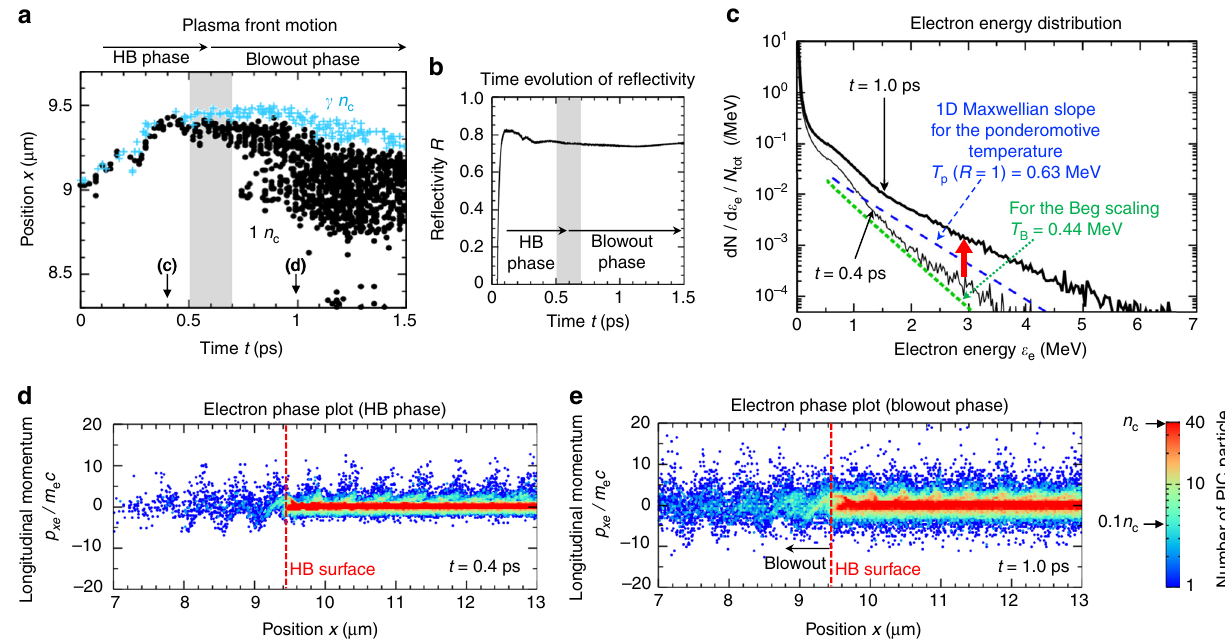
Fig. 2 PIC simulation results for the interaction of the linearly polarized laser fi eld. The laser intensity is the same as that in Fig. 1. a shows the time evolution of positions of the critical density n e = (1 ± 0.1) n c (black dots) and relativistic critical density n e = ( γ ± 0.1) n c (blue crosses), where γ ¼ (cid:4) (cid:5) 1 = 2 is the relativistic factor of electrons and ε 2 = 1 for linearly polarized lasers. In obtaining γ , the re fl ectivity R at the transition time from = 2 1 þ ð 1 þ R Þ ϵ 2 ^ a 2 0 the hole boring (HB) to the blowout is used. b Time evolution of the re fl ectivity. The shaded areas in a , b correspond to the transition interval from the HB to the blowout. In c , the electron energy distributions at t = 0.4 and 1 ps are shown by black thin and bold lines, respectively. The slopes of the one- dimensional relativistic Maxwellian energy distribution function > 0.5 MeV are shown by the blue-dashed and green-dotted lines assuming the ponderomotive temperature at the maximum re fl ectivity R = 1, that is T p = 0.63 MeV, and the Beg scaling T B = 0.44 MeV, respectively. d , e are the electron phase plots in the longitudinal x direction at times t = 0.4 and 1 ps,